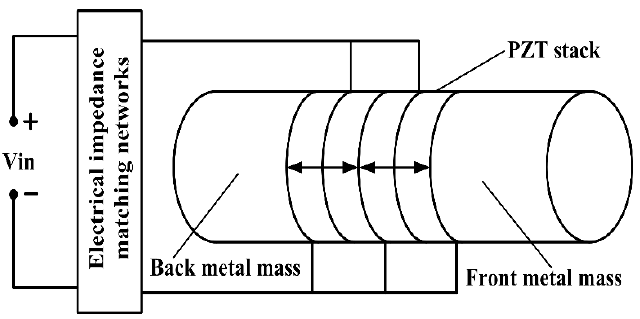
Figure 2. The sandwiched piezoelectric ultrasonic transducer with EIM networks.